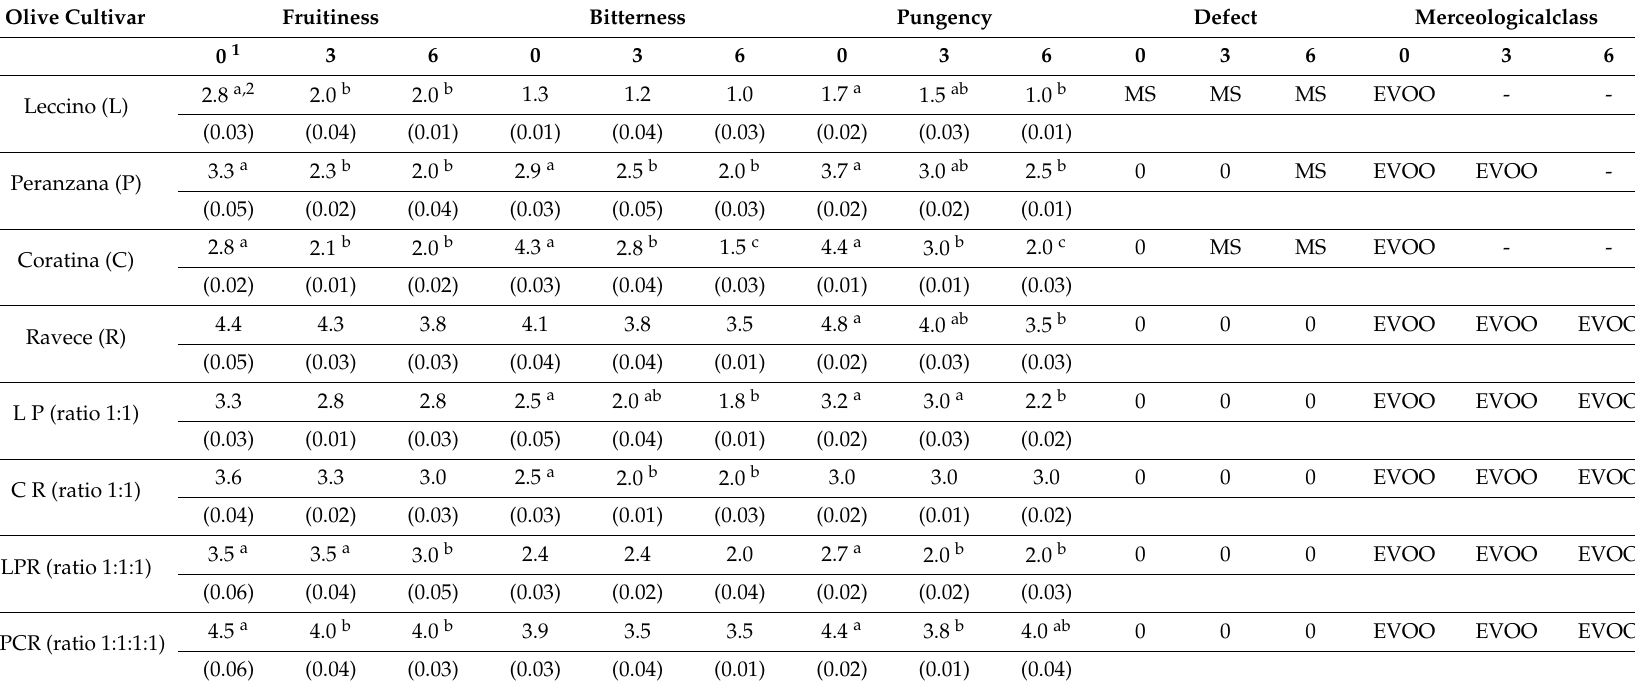
Table 7. Sensory attributes of monovarietal and blended extra virgin olive oils (EVOOs) during storage. Olive